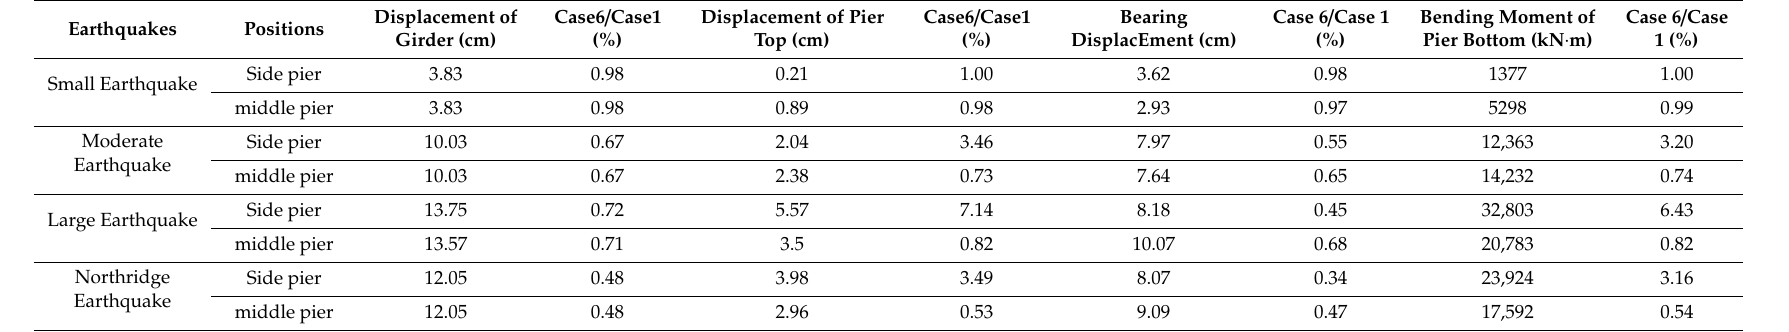
Table 4. Seismic responses of bridge under di ff erent